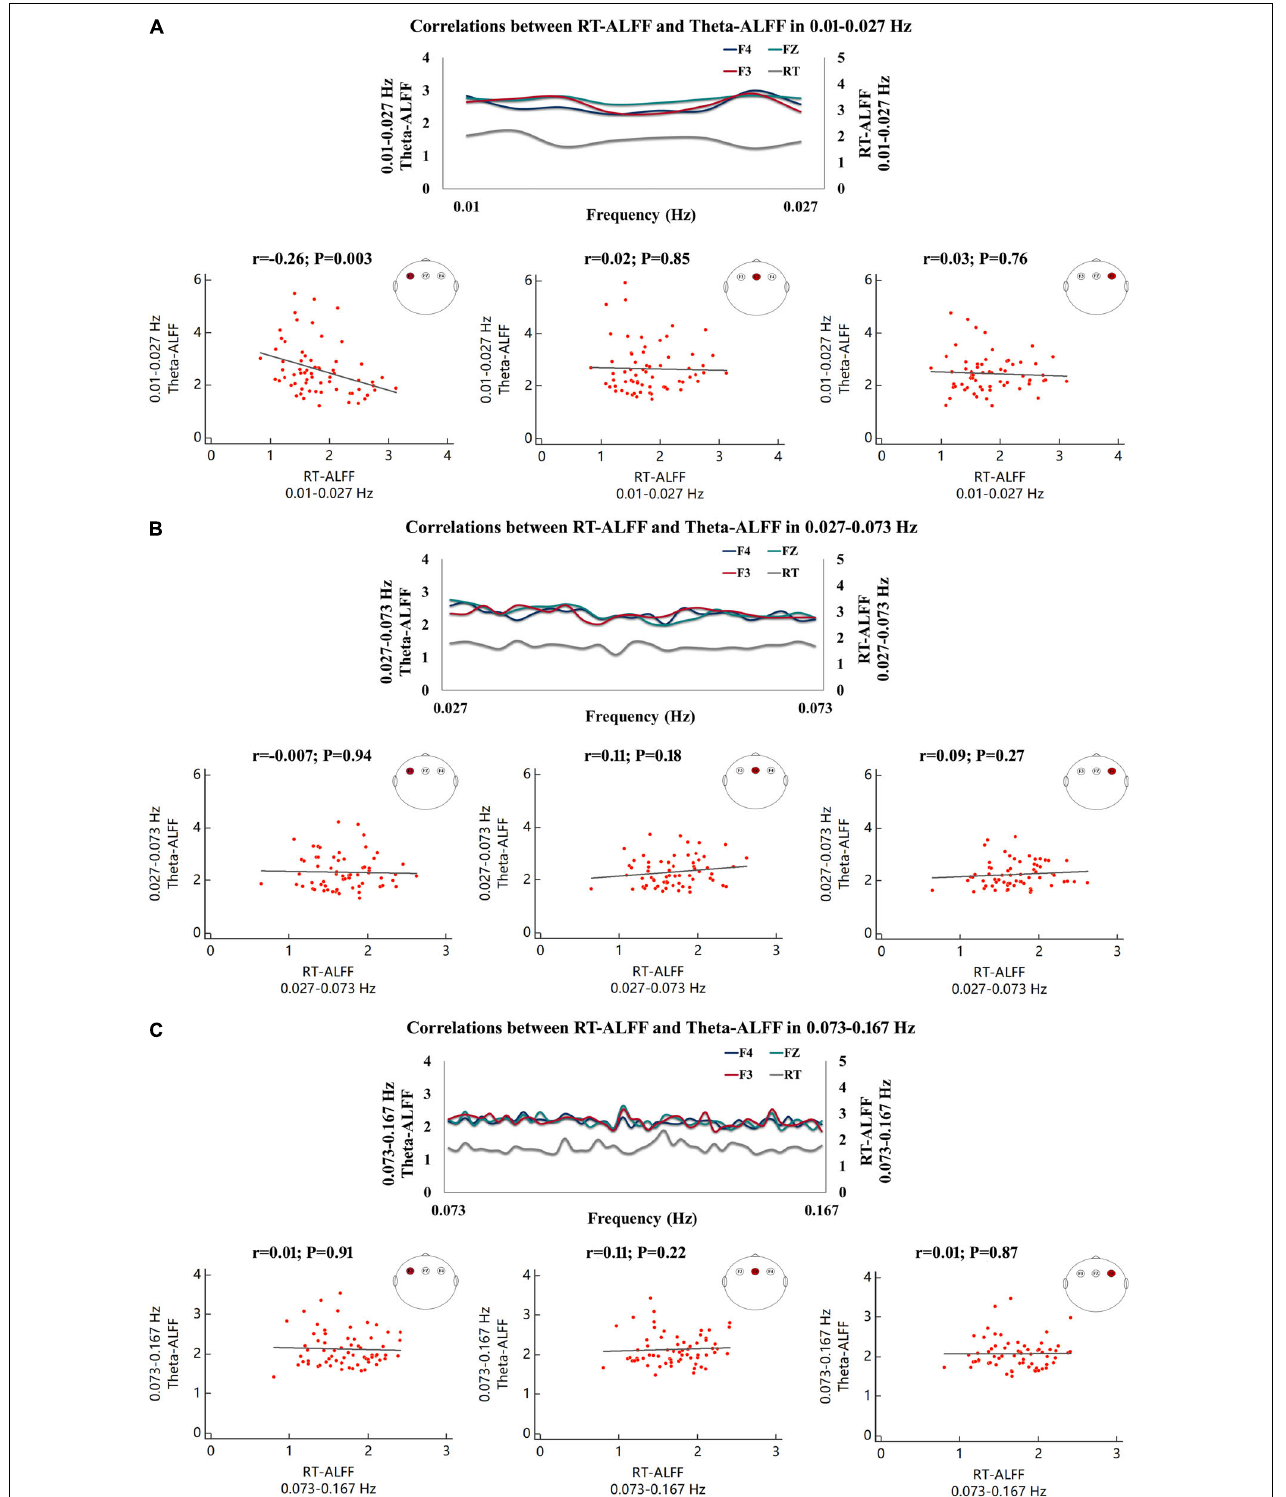
FIGURE 5 | Correlations between RT-ALFF and Theta-ALFF in each frequency band. The correlation (Kendall rank correlation) between RT-ALFF and Theta-ALFF (at the electrodes of F3, FZ, and F4) is shown in 0.01–0.027 Hz (A) , 0.027–0.073 Hz (B) , and 0.073–0.167 Hz (C) . The amplitude of reaction time fluctuation and trial-by-trial theta activity (at the electrodes of F3, FZ, and F4) were also depicted in the frequencies of 0.01–0.027 Hz (A) , 0.027–0.073 Hz (B) , and 0.073–0.167 Hz (C) .